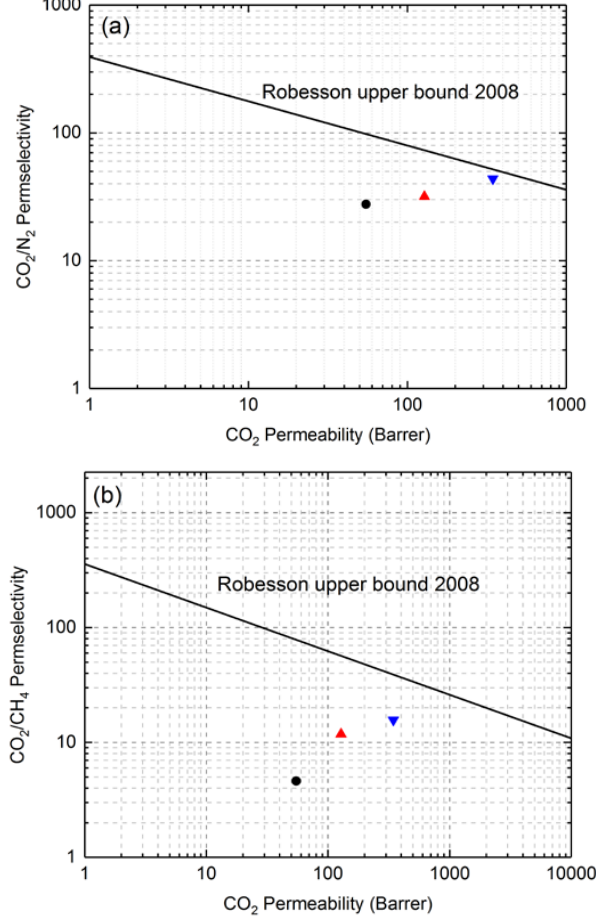
Figure 7. Robeson plot for ( a ) CO 2 /N 2 and ( b ) CO 2 /CH 4 gas pair showing data for PEG-based polybenzoxazine films measured at 30°C. [ ● —Poly(BZ-JD230), ▲ —Poly(BZ-JED600), and ▼ — Poly(BZ-JED900)].